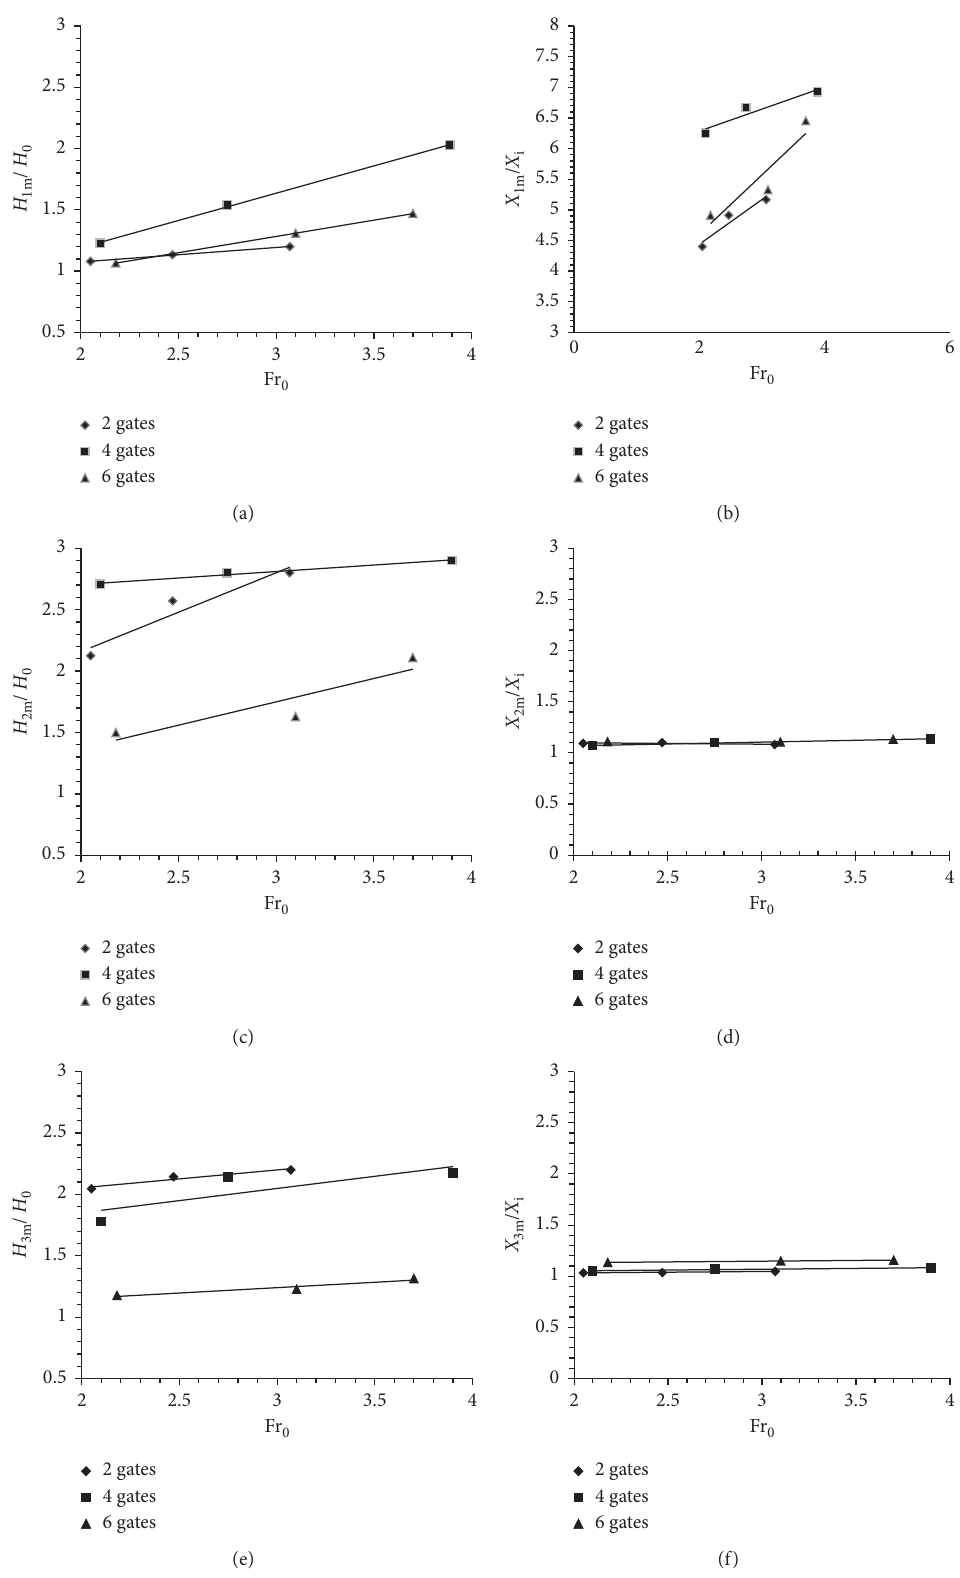
Figure 15: Dimensionless curves of maximum height variation and their formation location in terms of the Froude number for different gate